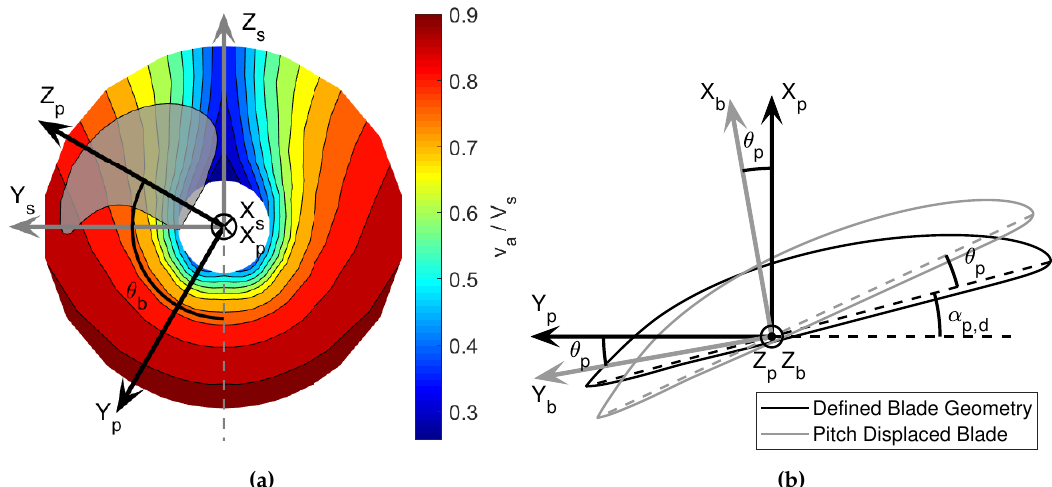
Figure 3. ( a ) Ship and propeller coordinate system and definition of the position of the propeller blade in wake field θ b . ( b ) Propeller and blade coordinate system and definition of the pitch displacement of the propeller blade θ p